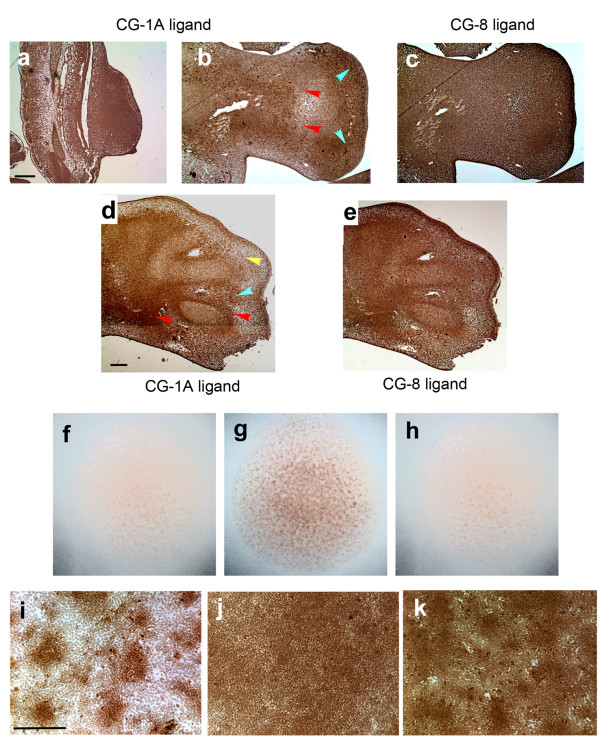
Dynamics of the CG-1A and -8 binding reactivity in chicken leg bud mesenchyme. (a) Staining by biotinylated CG-1A for its binding sites in a 3½-day chicken leg section. (b) Staining for CG-1A binding reactivity in 5-day leg sections in the zeugopod (red arrowheads) and in the autopod (blue arrowhead) and a more diffuse spatial localization of CG-8 binding reactivity (c). (d) Staining showing CG-1A binding reactivity in a 6-day leg-bud in the prospective digit primordia (red arrowheads), moderate staining in the interdigital mesenchyme (blue arrowhead) and lack of staining in the interstitial mesenchyme (yellow arrowhead), and (e) more diffuse staining for CG-8 binding reactivity. Images (a-c) have the same scale, as do images (d) and (e), with the scale bars in (a) and (d) representing 1 mm. (f-h) Micromass cultures of leg bud mesenchyme at 15 h of incubation. The culture in (g) shows the spatial pattern of CG-1A binding reactivity using a biotinylated CG-1A probe. The two flanking panels show control cultures. In (f) the biotinylated CG-1A probe was omitted and in (h) the culture was treated with probe that had been pre-incubated overnight with 50 mM lactose. Diameter of the micromass cultures, ~3 mm. (i) Condensation-specific expression of CG-1A-reactive sites in a 2-day leg micromass culture. (j) Addition of 10 μg/ml CG-1A increases extent of its reactivity and expands its localization to precondensation cells, in contrast to the nodular pattern seen in the untreated culture (i). (k) Staining profile of CG-8-reactive sites with biotinylated CG-8 in 2-day leg micromass culture show them to be present both outside and inside condensations. The staining within the condensations is more intense than in the pericondensation regions. Images (i-k) are at the same magnification; scale bar in (i) represents 0.2 mm.